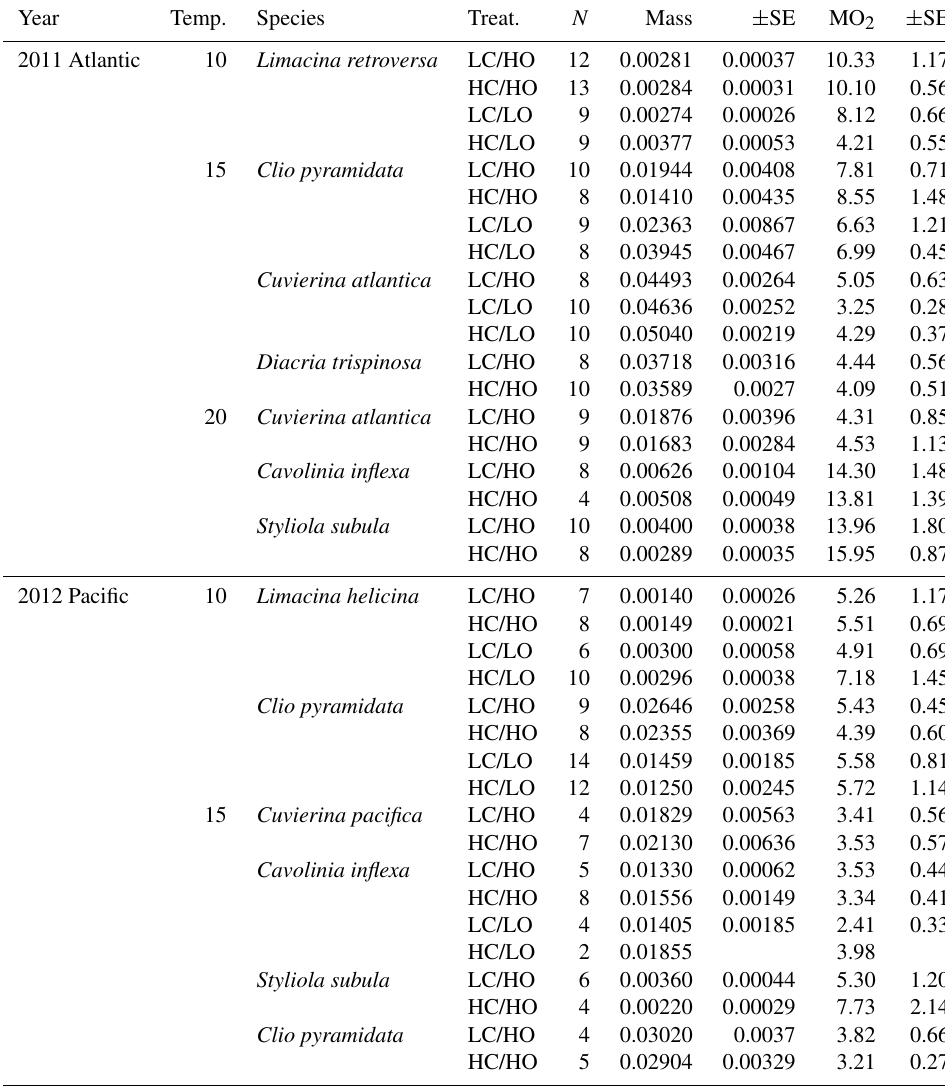
Table 4. The average wet mass (mass; g ) and mass-specific oxygen consumption rate (MO 2 ; µmolO 2 g − 1 h − 1 ) ± the standard error (SE) for each treatment (Treat.) and species. The numbers of replicates ( N ) per treatment are reported and the species are arranged by temperature (Temp; ◦ C) as well as the year and basin of